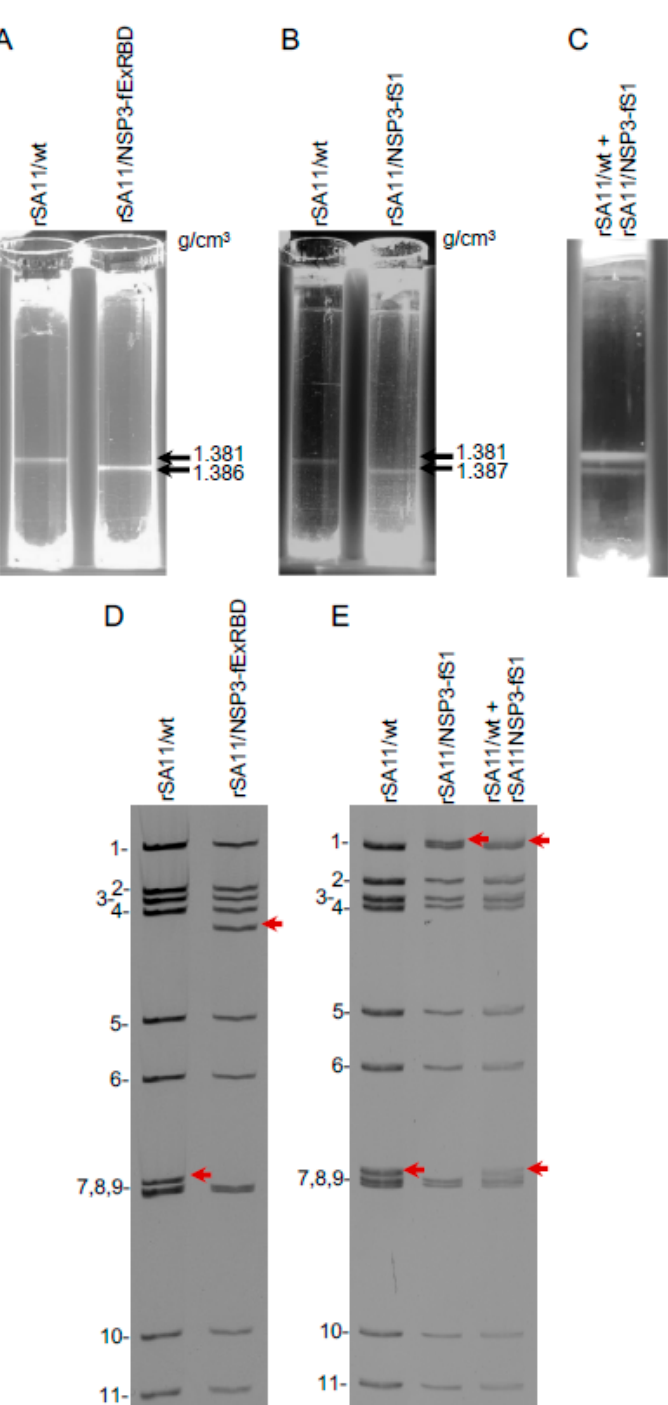
Figure 6. Impact of genome size on rotavirus particle density. MA104 cells were infected with rSA11/wt, rSA11/NSP3-fExRBD, or rSA11/NSP3-fS1 viruses at an MOI of 5. At 12 h p.i., the cells were recovered, lysed by treatment with non-ionic detergent, and treated with EDTA to convert ro- tavirus virions into DLPs. ( A , B ) DLPs were banded by centrifugation in CsCl gradients and densities (g/cm 3 ) were determined using a refractometer. ( C ) Lysates from rSA11/wt and